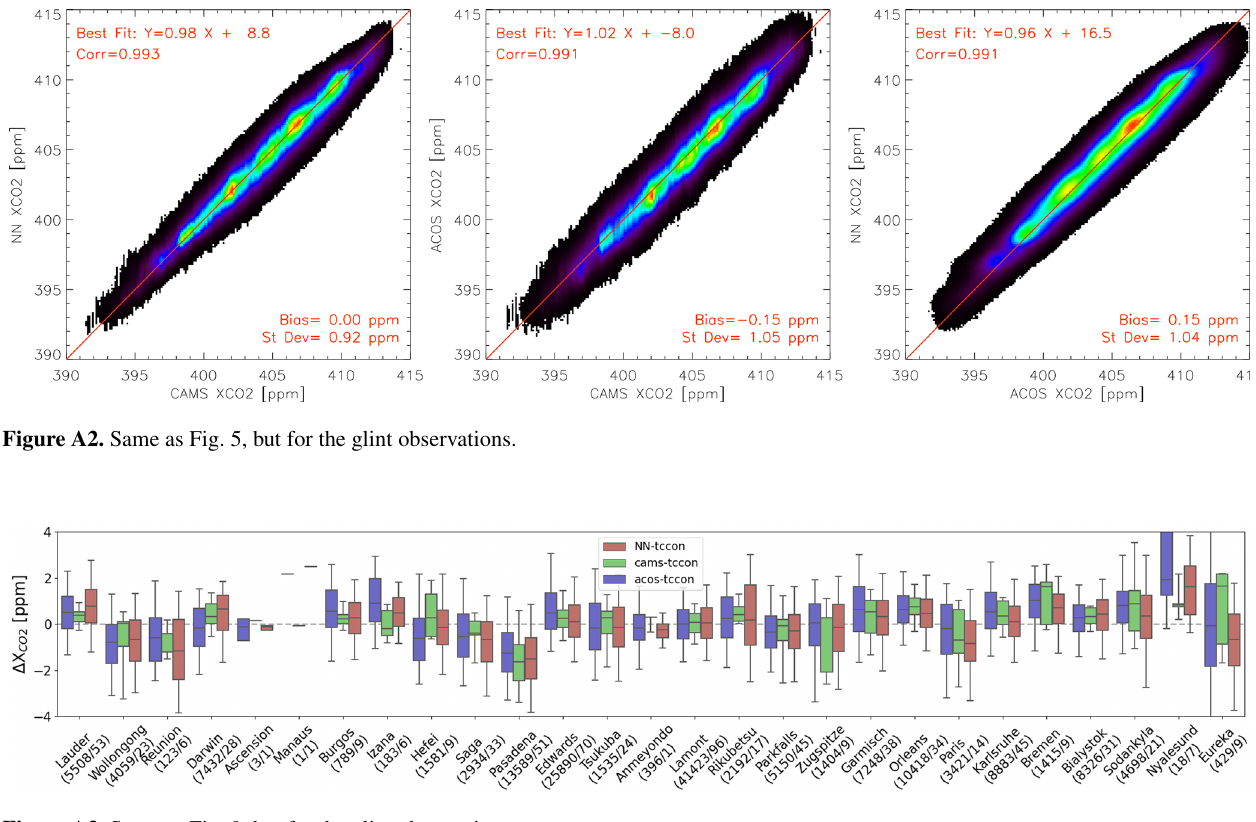
Figure A3. Same as Fig. 9, but for the glint